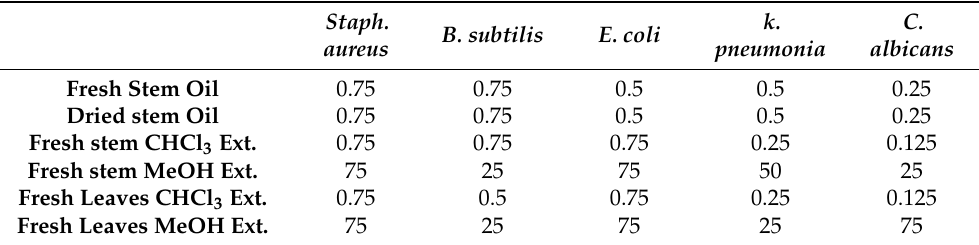
Table 3. MIC (mg/mL) of different essential oil and different extracts.